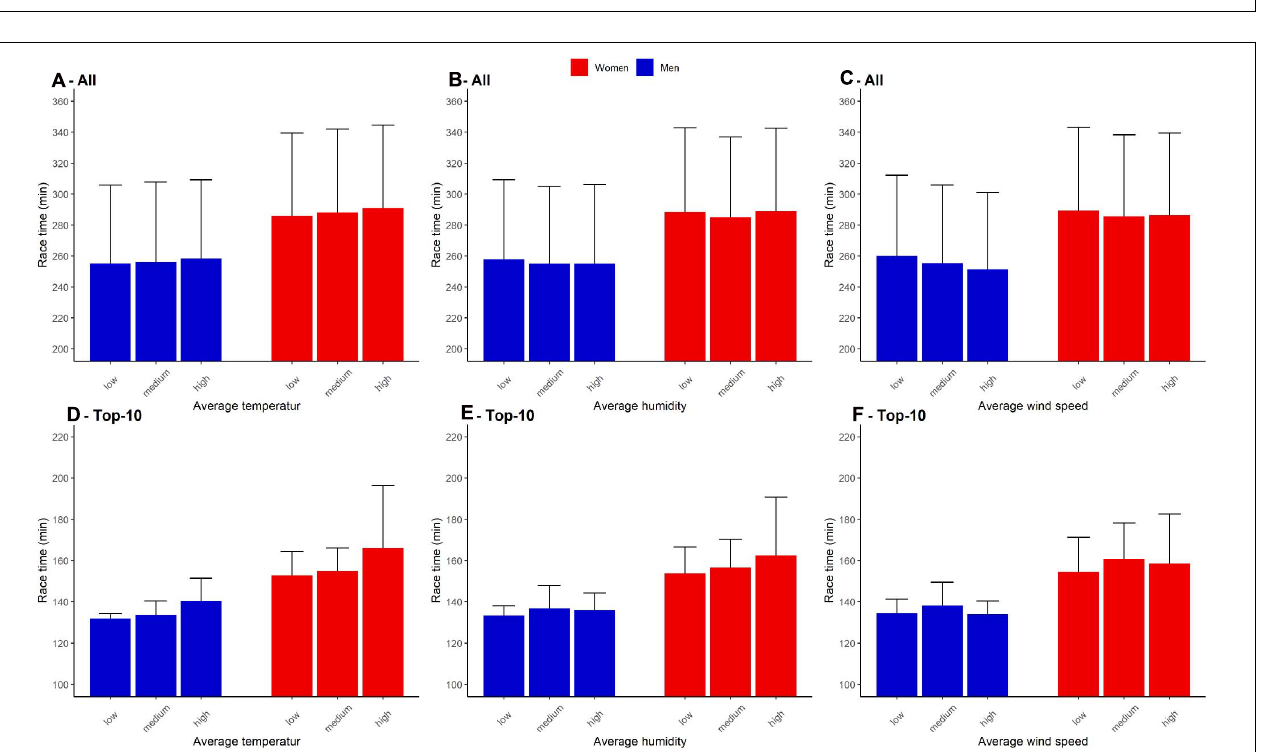
FIGURE 4 | Race time by performance level for temperature (A) , humidity (B) and wind speed (C) for all finishers and for top ten finishers (D–F)